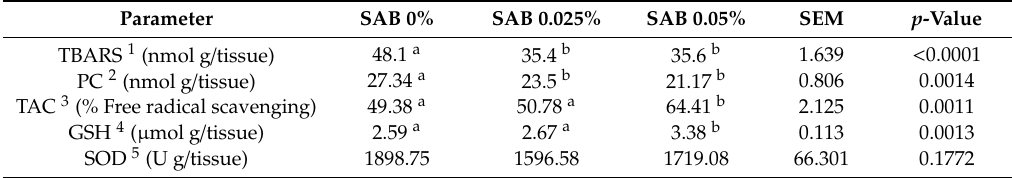
Table 4. E ff ect of dietary SAB powder on oxidative stress biomarkers in liver tissue.